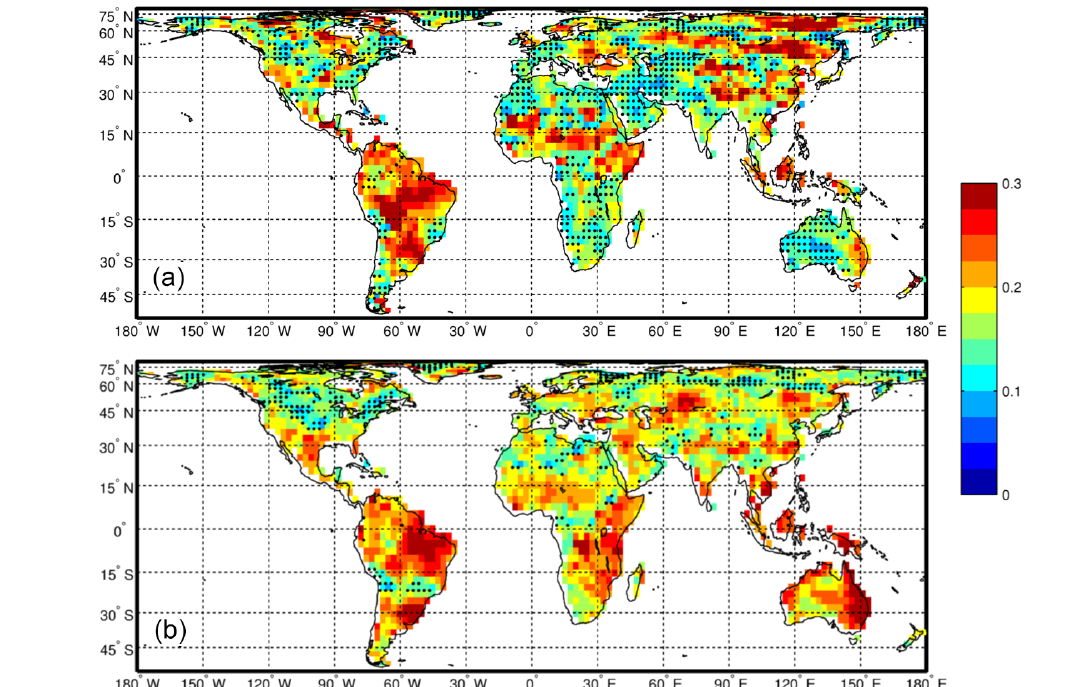
Figure 6. Ratio of the forced variance to the total variance. (a) The fraction of PRE variance forced by the SM which is also forced by the ET. (b) The fraction of PRE variance forced by the SM which is also forced by the LAI. Dots are placed over areas where variance ratio values did not pass a significance test at the 1% level.